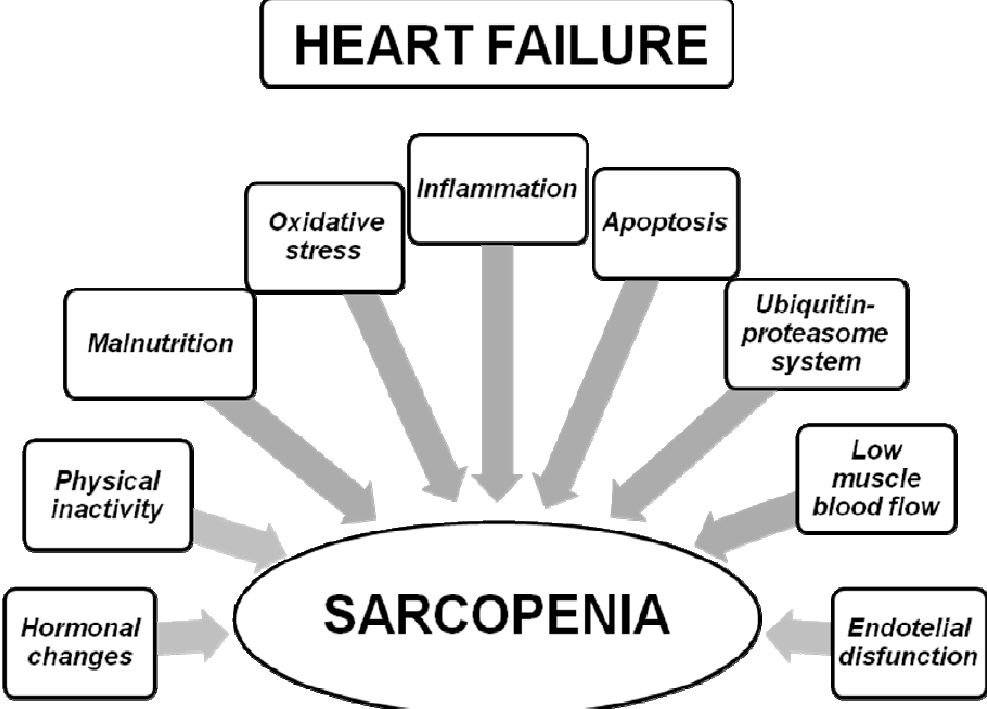
Figure 2. Factors related to heart failure, potentially leading to